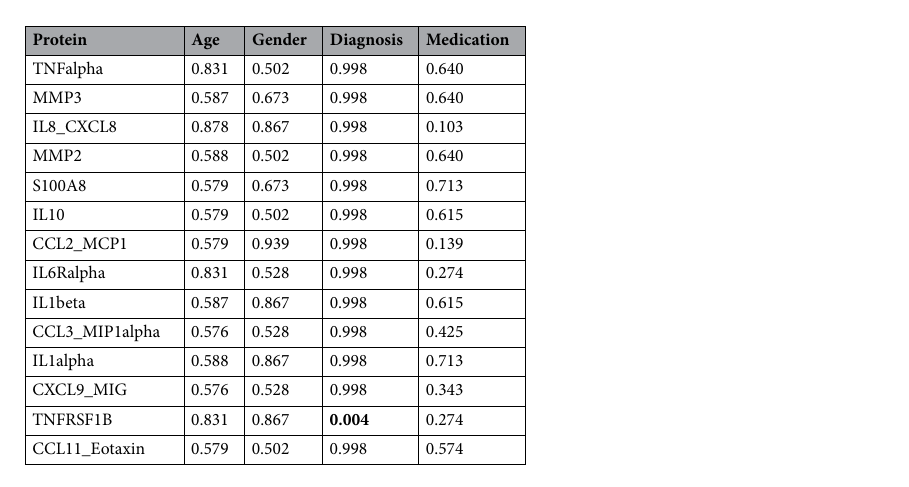
Table 2. Associations between protein levels in saliva and age, gender, sub-diagnosis, as well as medication in children with juvenile idiopathic arthritis (JIA). FDRs are presented for the statistically significant association (FDR < 0.05 by Benjamini–Hochberg procedure). TNFRSF1B was significantly associated with diagnosis in the JIA group. Significant values are in bold.